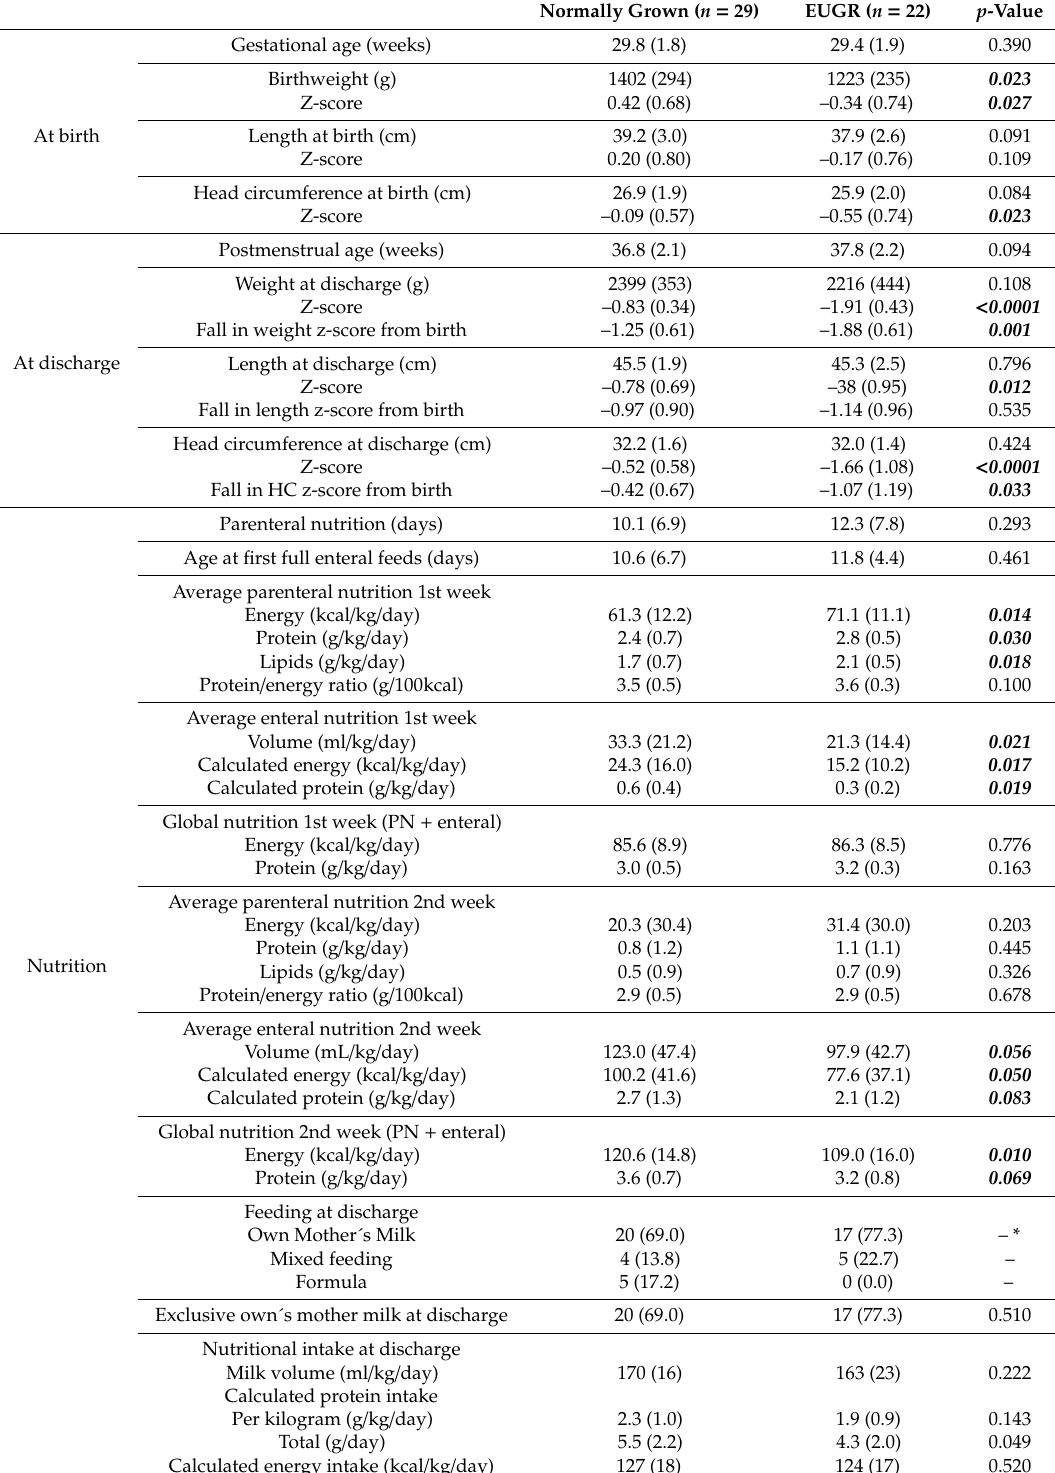
Table 1. Comparison of nutritional and growth parameters between normally grown and extrauterine growth restriction (EUGR) patients. Categorical values are represented as number (%) and continuous variables as mean (SD). Categorical values were compared with chi-square tests and continuous variables with Student´s t